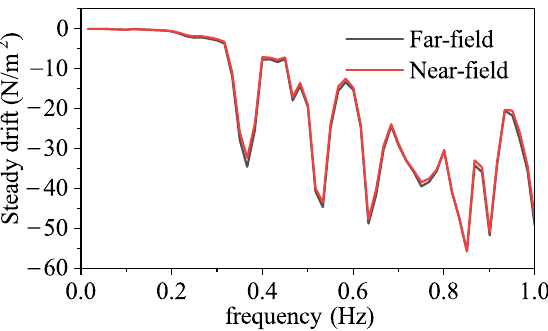
Figure 8. The comparison of steady drift between near-field and far-field